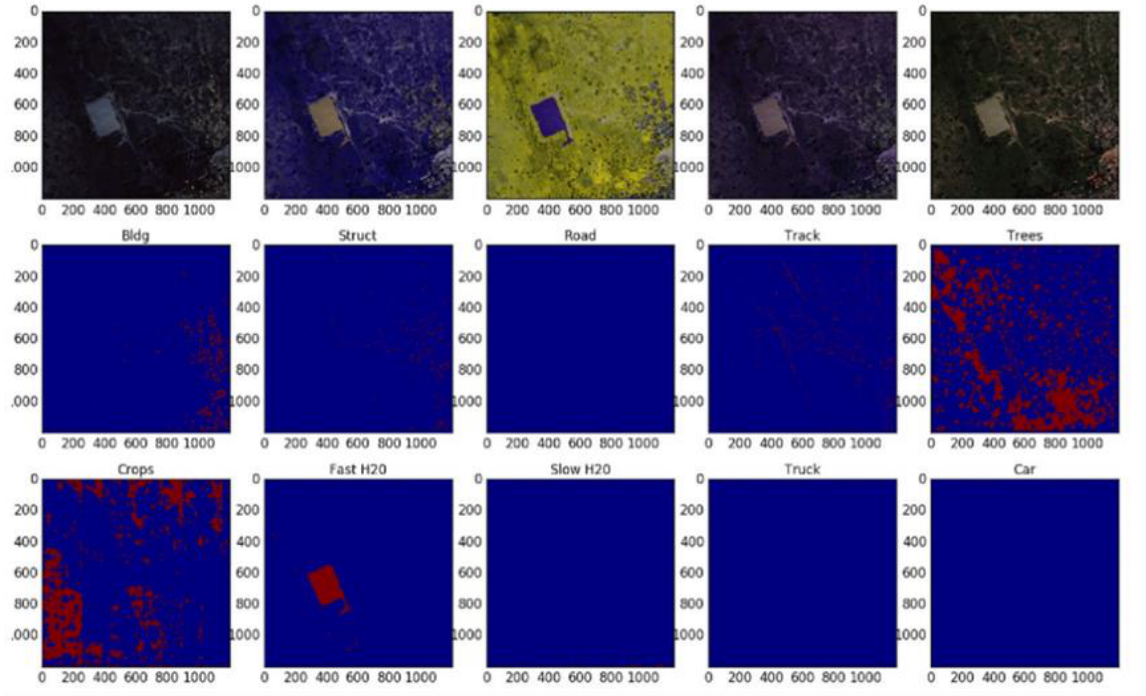
Fig.4. Initial preliminary identification of all categories of